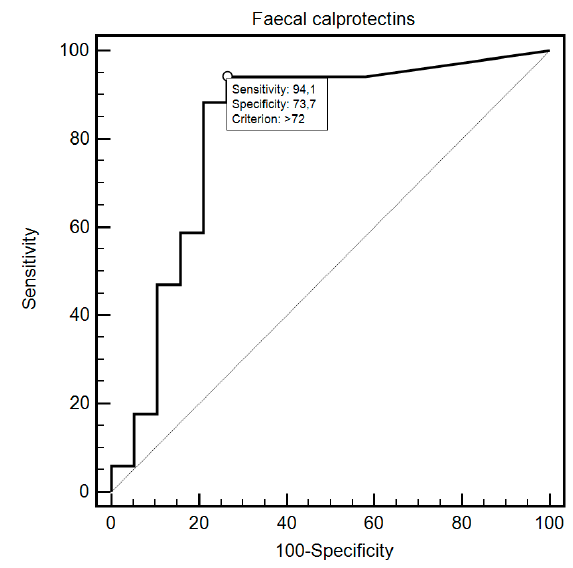
Figure 3. ROC curve illustrating the diagnostic usefulness of fecal calprotectin in SIBO detection in SSc patients. Table 4. The clinical value of fecal calprotectin in detecting SIBO, predicting eradication efficacy, and differentiating different clinical characteristics.